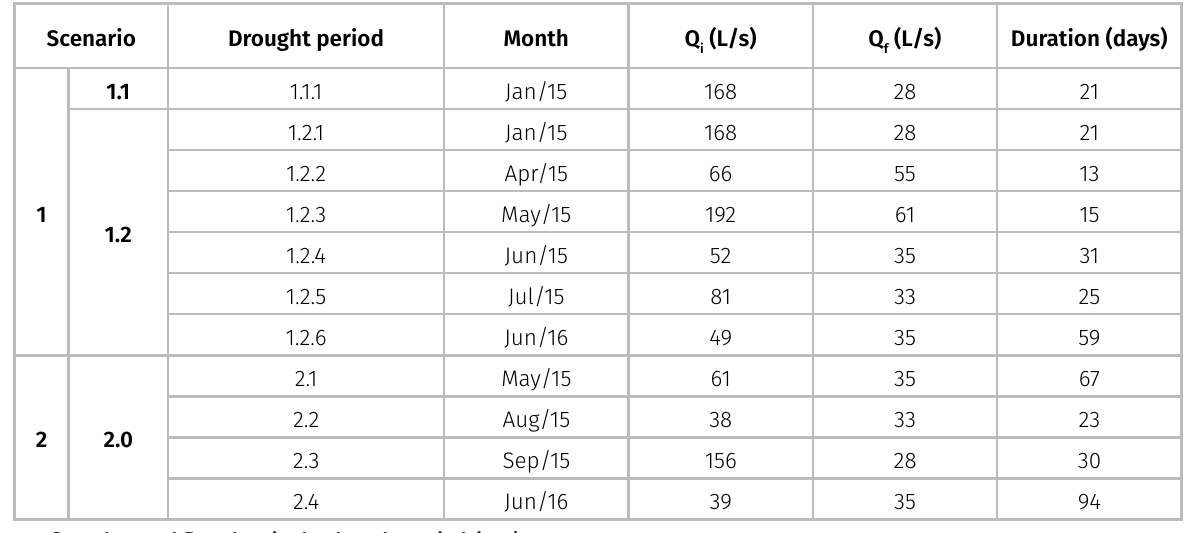
Table I. Observed drought periods in Scenarios 1 and 2.